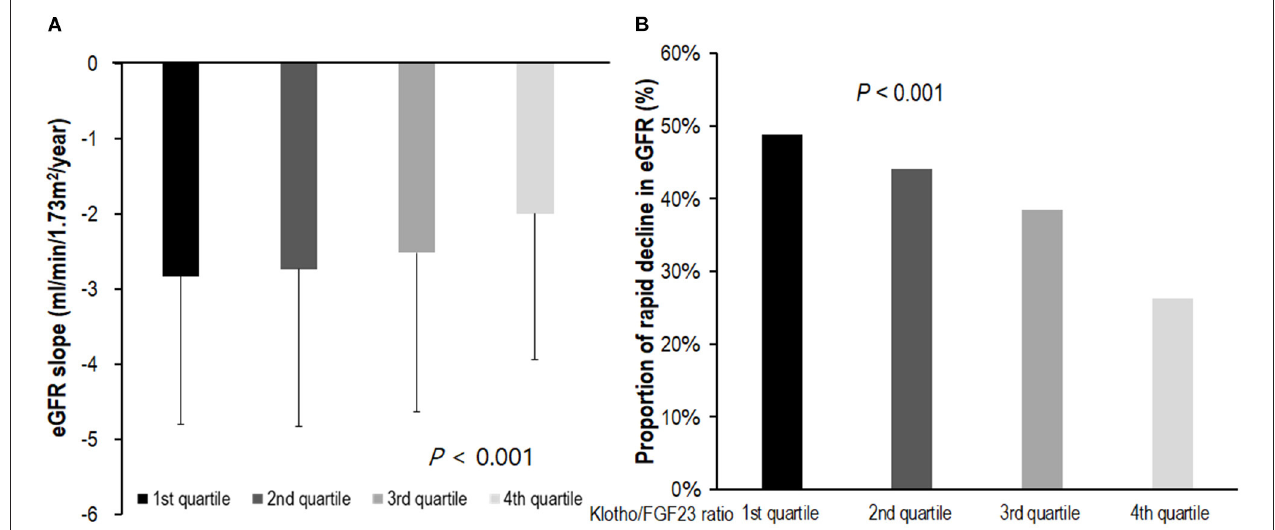
FIGURE 3 | The eGFR slope and rapid decline of eGFR according to Klotho/FGF23 ratio. (A) The eGFR slope according to Klotho/FGF23 ratio; (B) rapid decline of eGFR according to Klotho/FGF23 ratio. The eGFR slope was analyzed in 1,851 patients for whom eGFR was measured more than three times during the follow-up period. The eGFR slope was lower in the low Klotho/FGF23 ratio group ( P < 0.001; A ). The rapid decline of kidney function was defined as an estimated glomerular filtration rate (eGFR) < -3 ml/min/1.73 m 2 /year. The proportion of patients exhibiting a rapid decline of eGFR was higher in the first quartile of Klotho/FGF23 ratio group ( P < 0.001; B ). eGFR, estimated glomerular filtration rate by CKD-EPI creatinine equation; FGF23, fibroblast growth factor